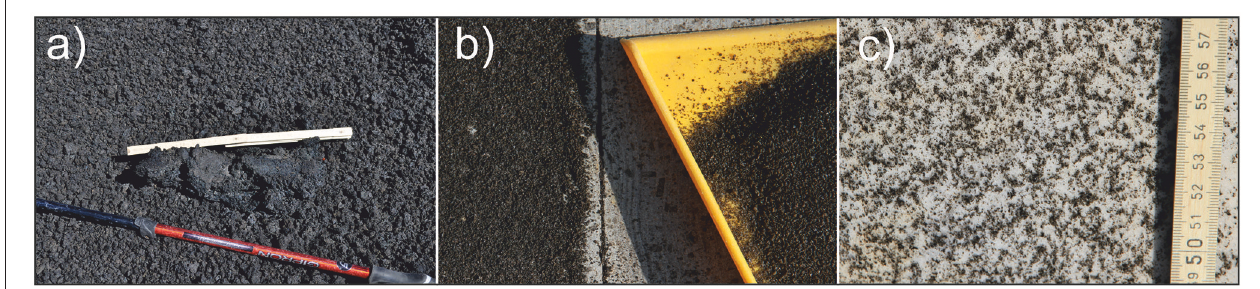
FIGURE 8 | The tephra deposit associated with the 25-26 October 2013 distal fallout. (a) Proximal lapilli layer and 40-cm sized scoria deposited at about 1km of distance from the NSEC; (b) continuous layer of ash deposit along the dispersal axis at 16km distant in Adrano; (c) lateral outcrop showing a scattered ash deposit in Adrano. Photos by D.